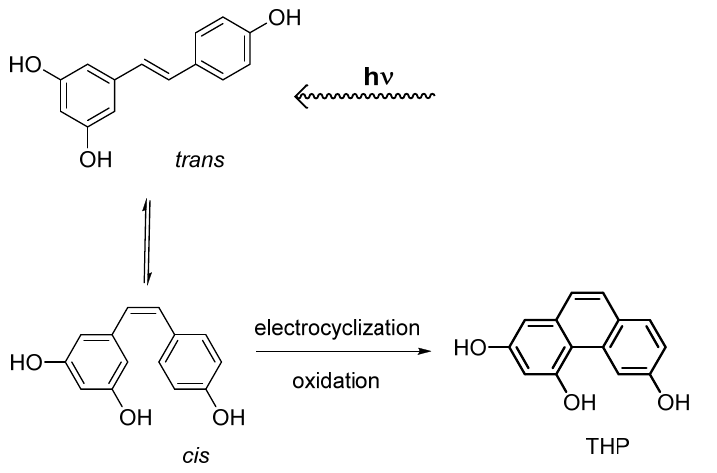
Figure 1. trans -Resveratrol photochemical isomerization and electrocyclization/oxidation.